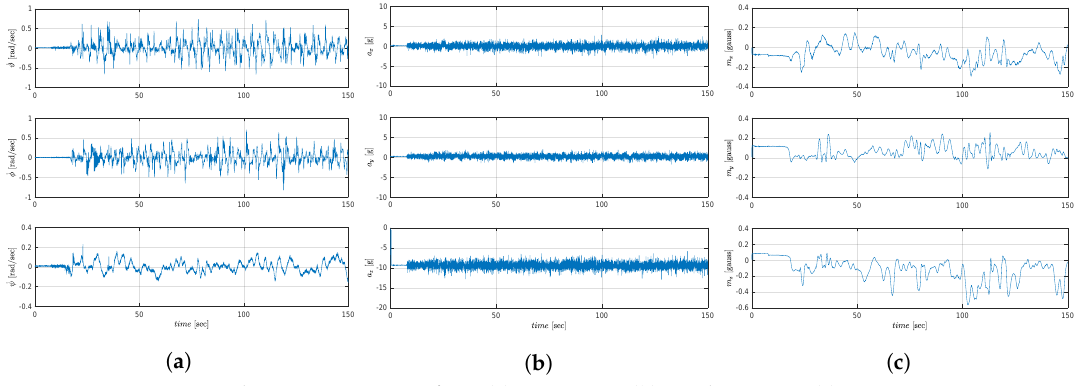
Figure 7. IMU data measurements from ( a ) gyroscope; ( b ) accelerometer; ( c )